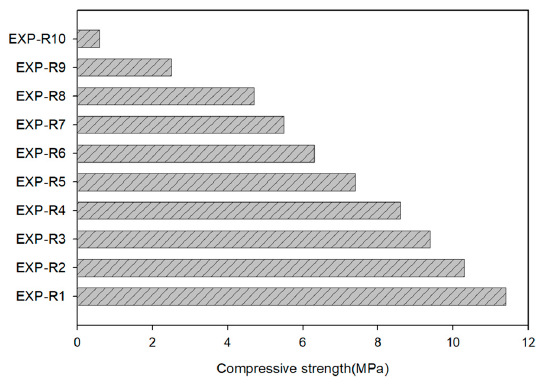
Figure 5. Compressive strength according to the ratio of cement and porous feldspar.